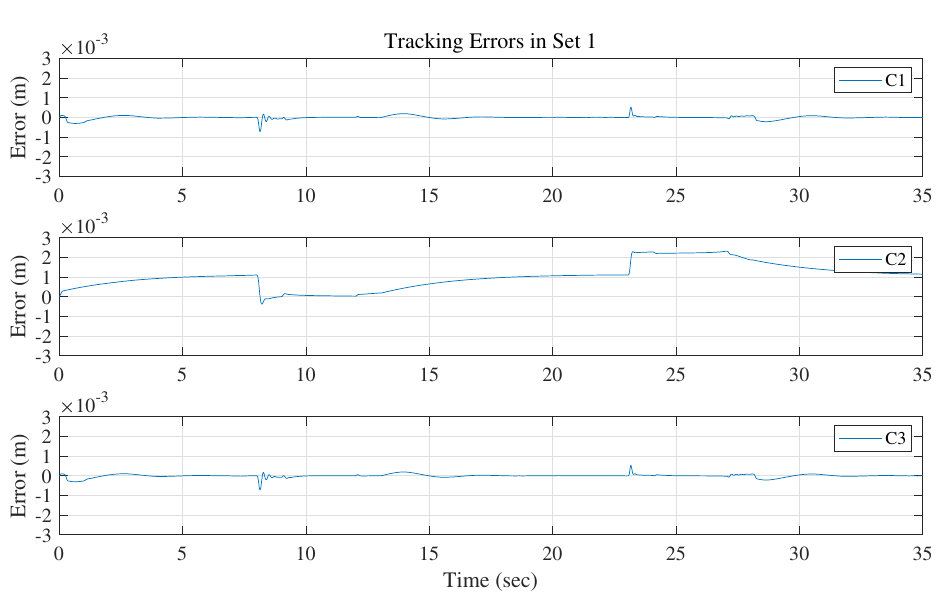
Figure 6. Motion tracking errors comparison in Set